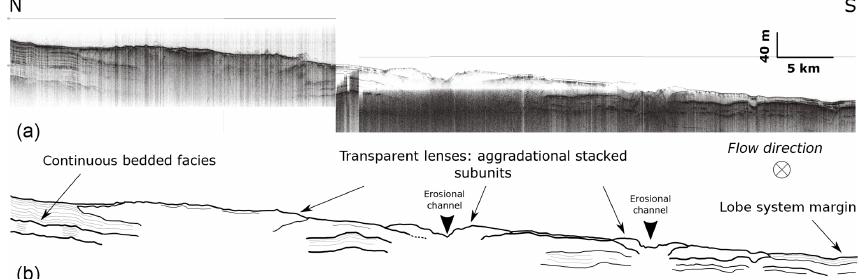
Figure 12. (a) Transverse 3.5kHz very high-resolution seismic line and (b) line drawing in the upper distal lobe area; see Fig. 11 for location of the